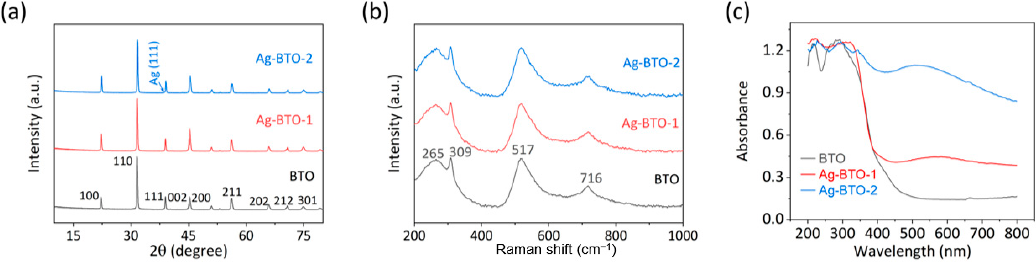
Figure 2. ( a ) XRD patterns, ( b ) Raman spectra, and ( c ) DRS spectra of the three samples.